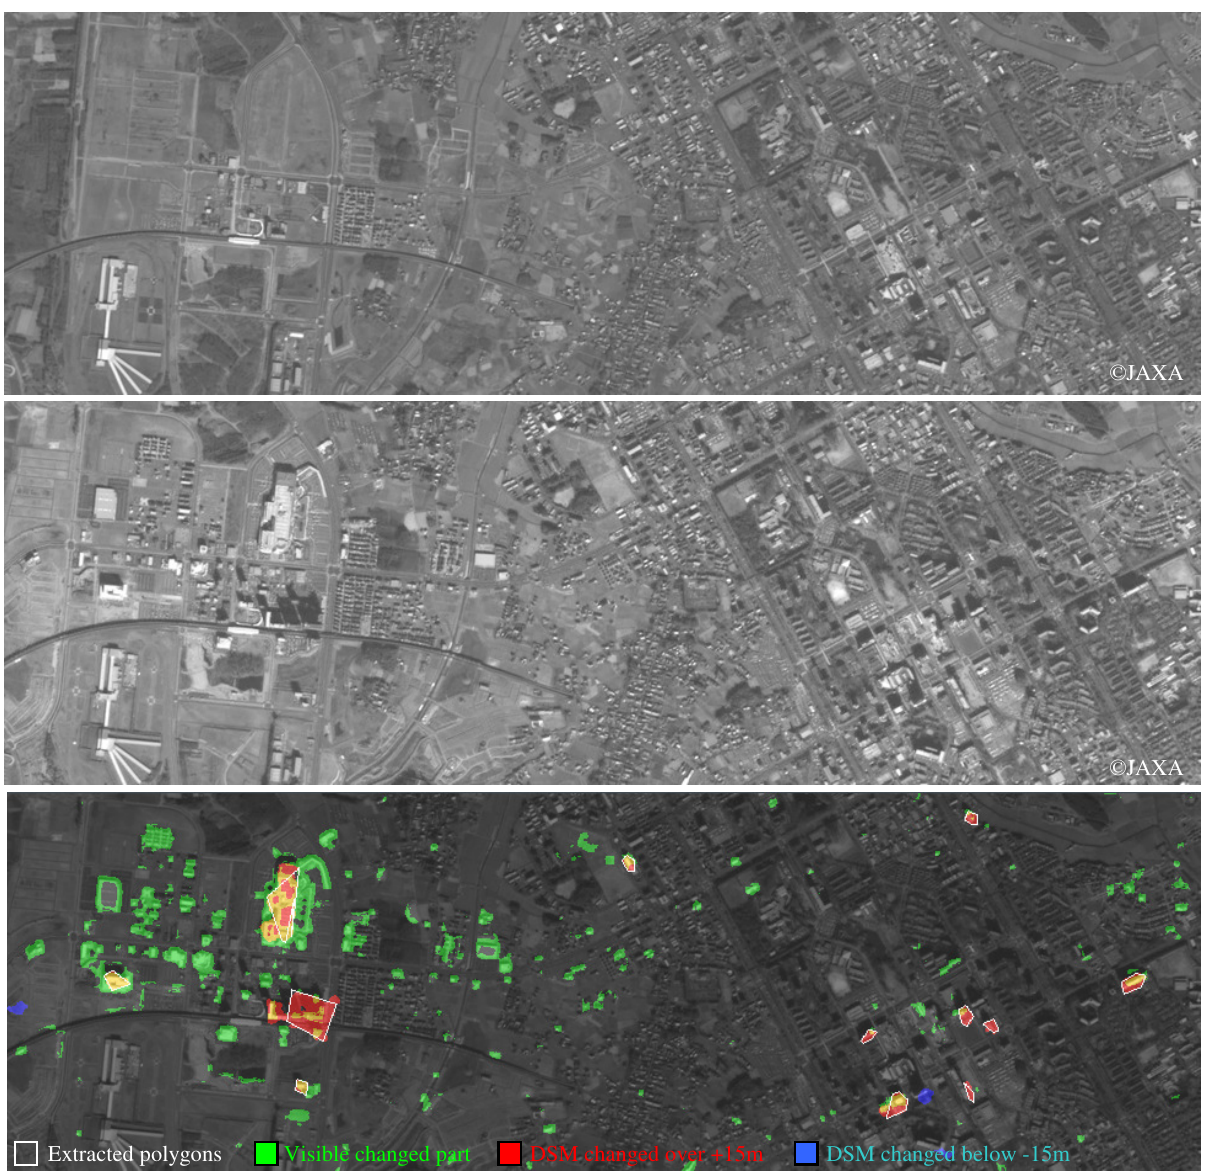
Figure 10: Part of change detected image Top: 1 st orthoimage, Center: 2 nd orthoimage, Bottom: change detected image overlayed with 2 nd orthoimage and extracted